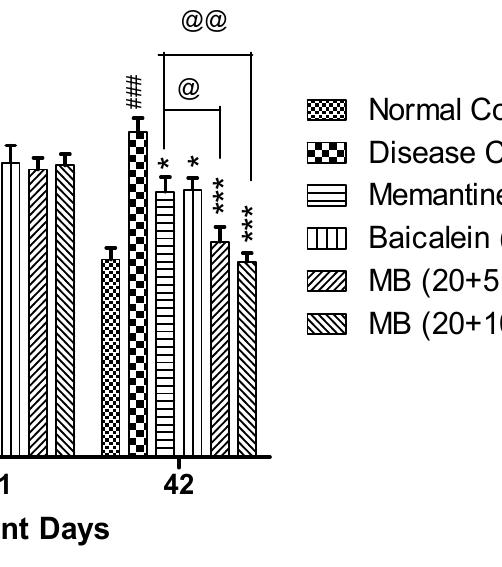
Figure 3. Elevated Plus maze—The transfer latency of each treatment group was plotted against treatment days (20, 21 and 42 days). Data are shown as mean ± SEM (n = 6) at p < 0.05. Comparison with normal control is indicated with ### p < 0.001, whereas comparison with disease control is indicated with * p < 0.05, *** p < 0.001, @ p < 0.05 and @@ p < 0.01 indicate comparison with memantine treatment group. MB: memantine +